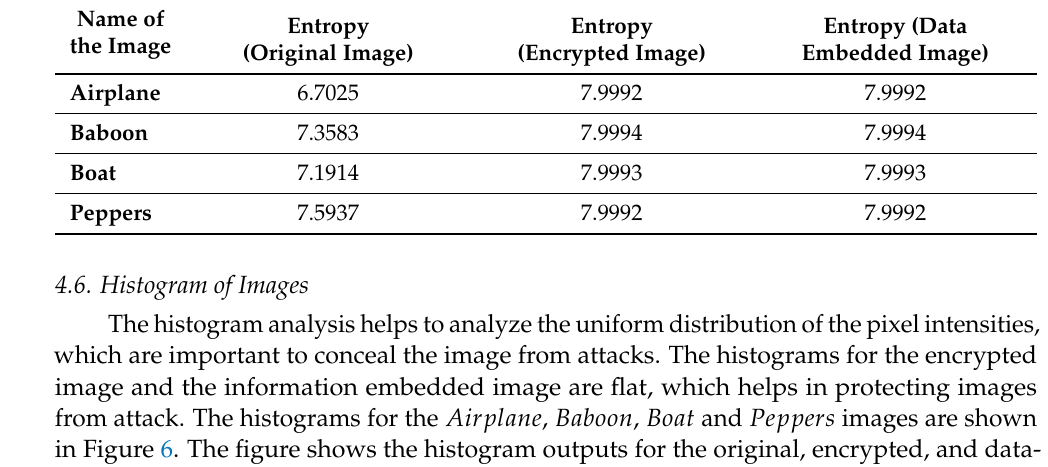
Table 4. Entropy measured on airplane, baboon, boat and peppers images.